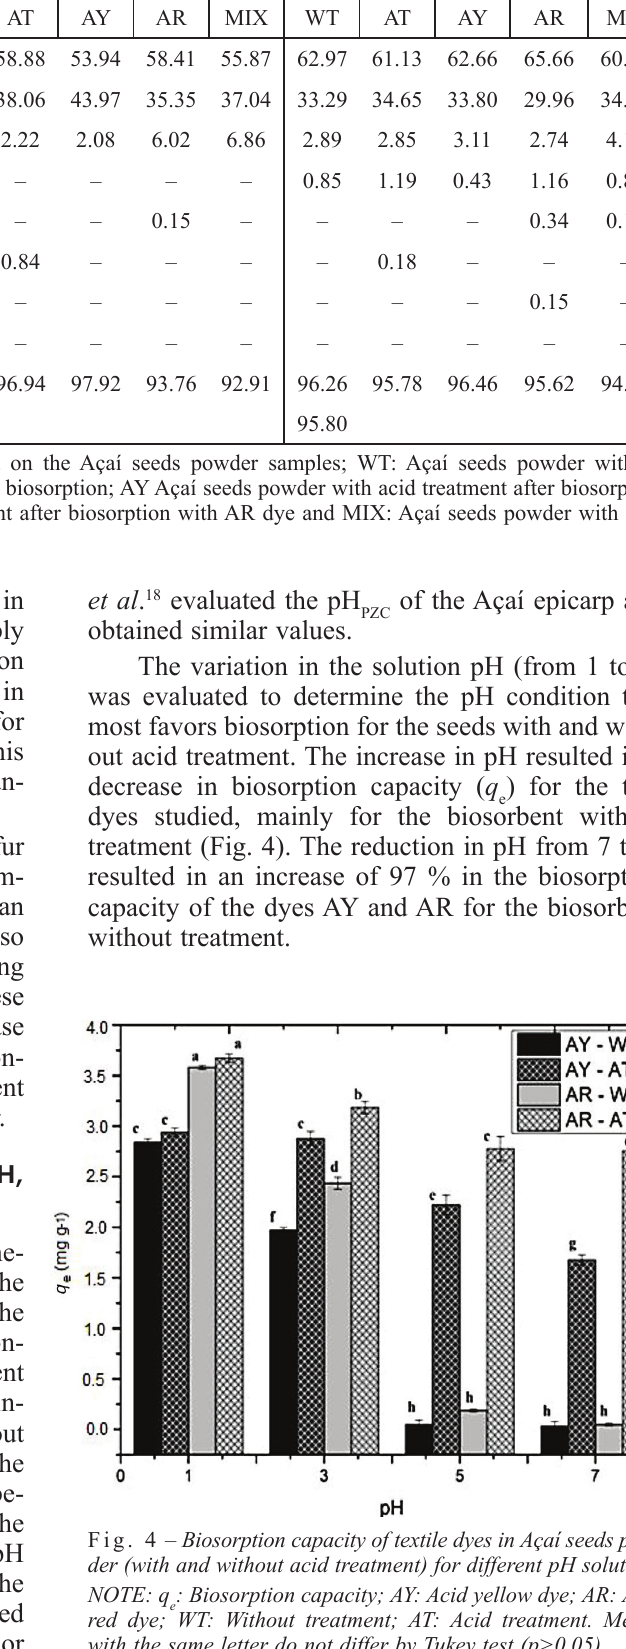
Table 2 – Energy dispersive X-ray (EDS) performed on the different structures of the Açaí seeds powder % S1